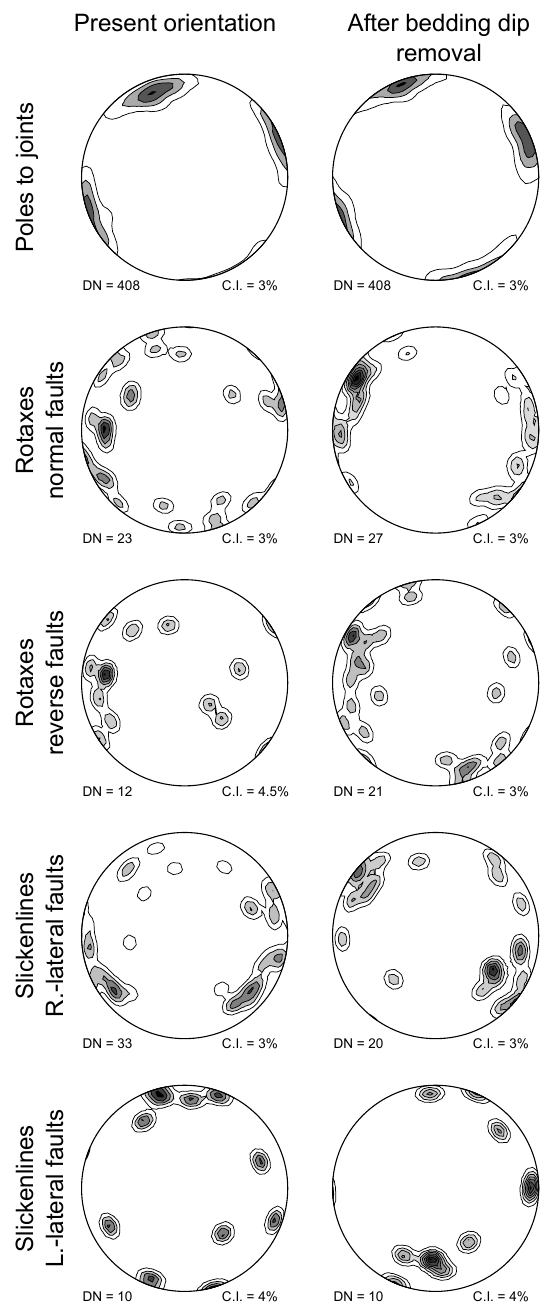
Fig. 8. Stereoplots of mesostructural data collected in the Poza de la Sal Diapir. DN and C.I. indicate the data number and the contouring interval,